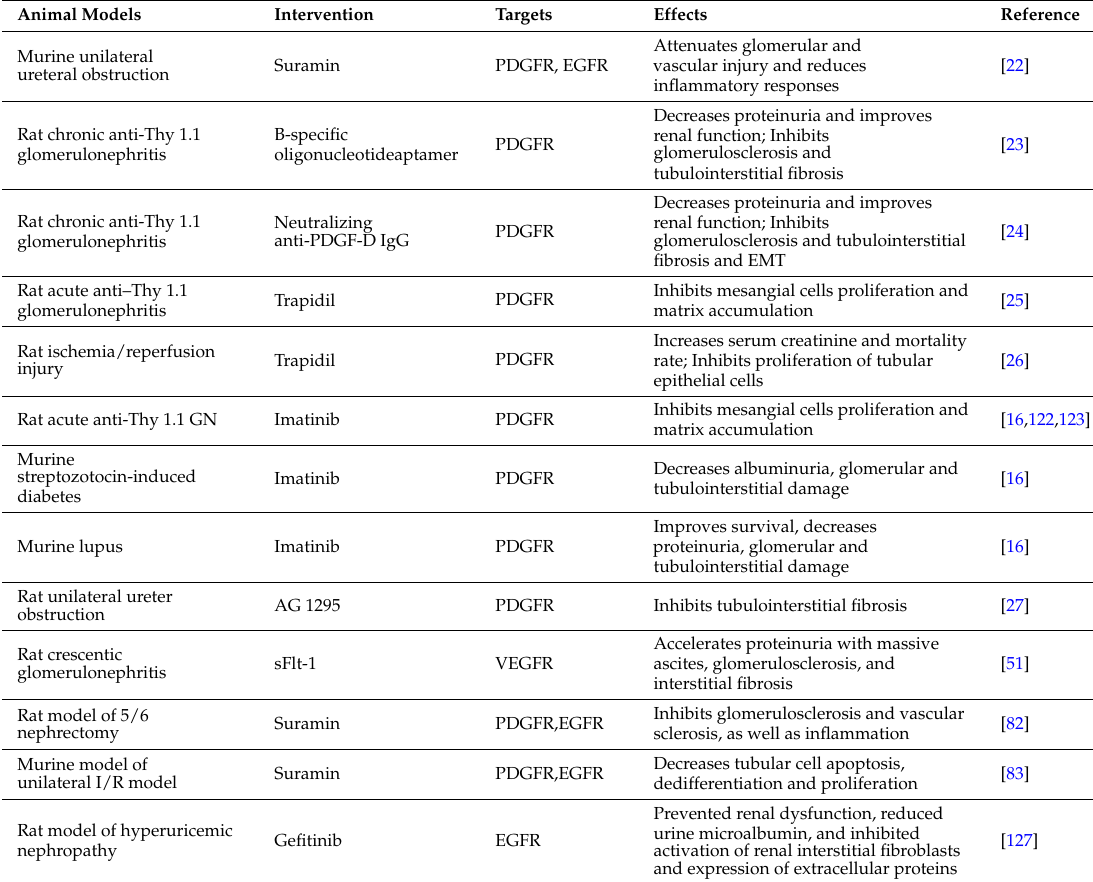
Table 2. Effects of TKIs in animal models of renal